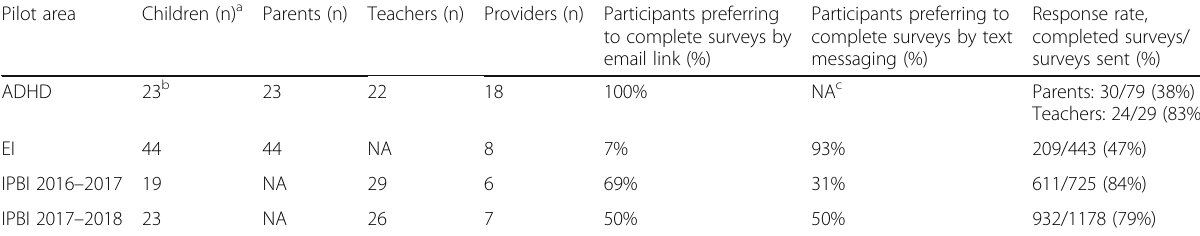
Table 2 TAILOR utilization characteristics Pilot